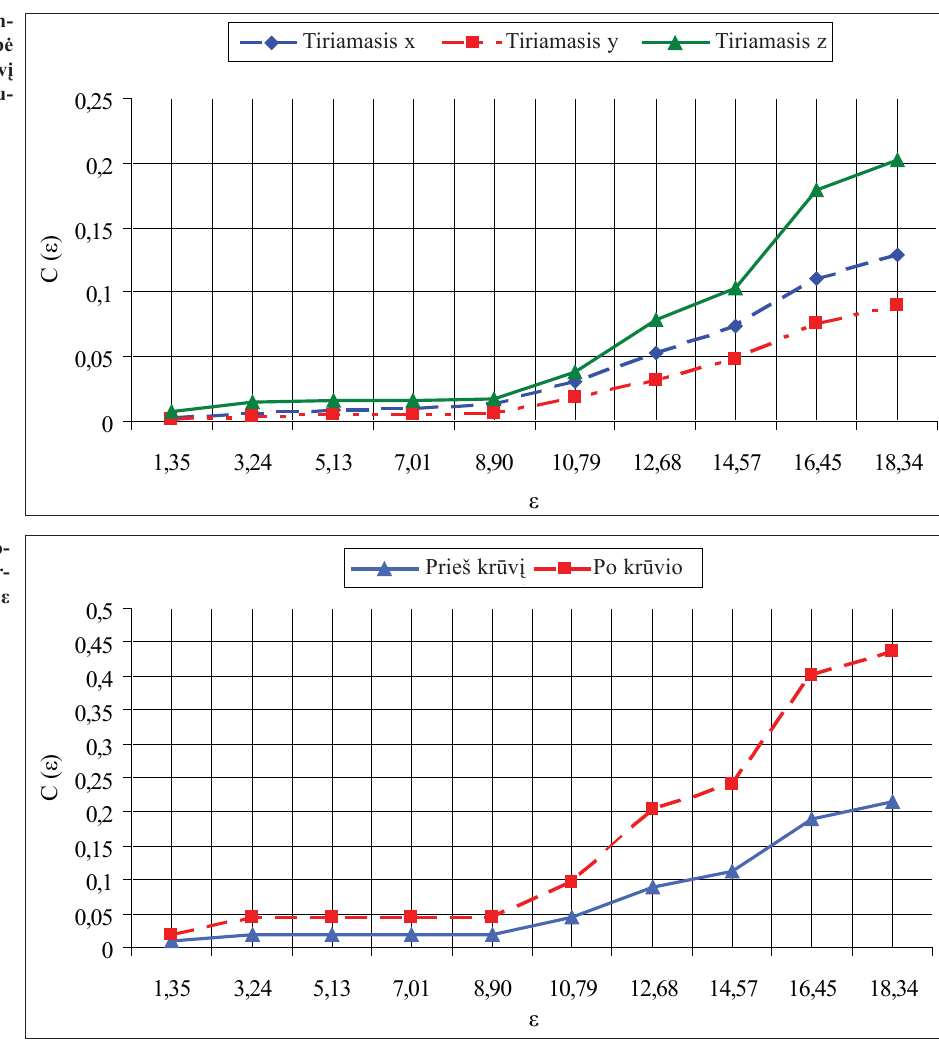
motorinius vyksmus (šiuo atveju Tepingo testo užduot į ), taip pat galime palyginti ir grupuojam ų interval ų